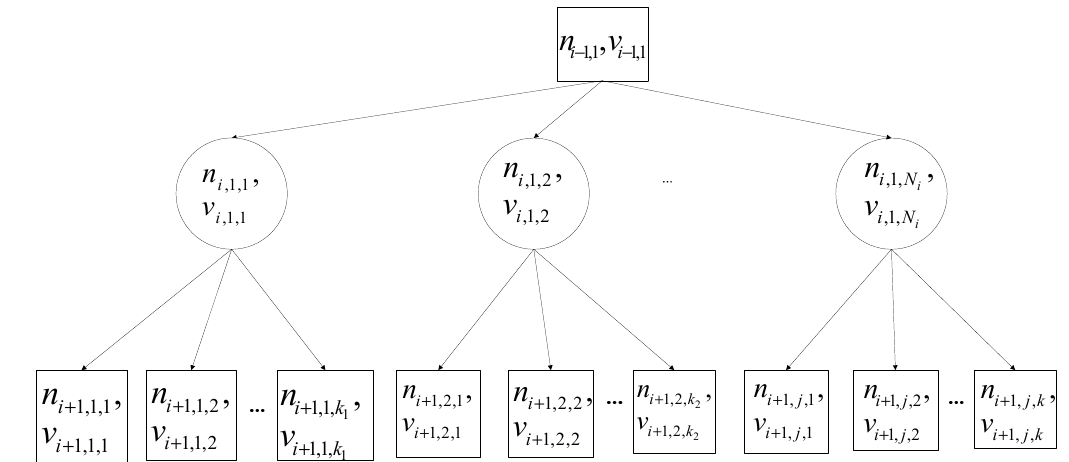
Figure 3. A min–max search tree is employed as an example for proof of Theorem 1. The rectangular nodes are max nodes, which are ordered increasingly from left to right according to their evaluations, and the circular nodes are min nodes, which are ordered decreasingly from left to right according to their evaluations.